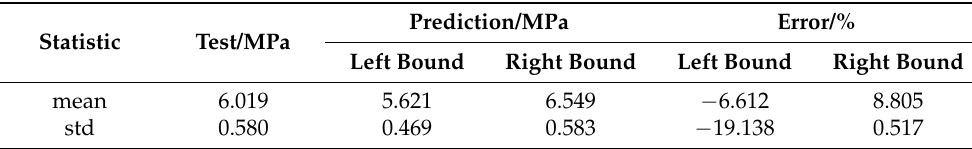
Figure 15. P-box of case II and its comparison with experimental results. Table 8. Stochastic characteristics of ultimate strength in case II.